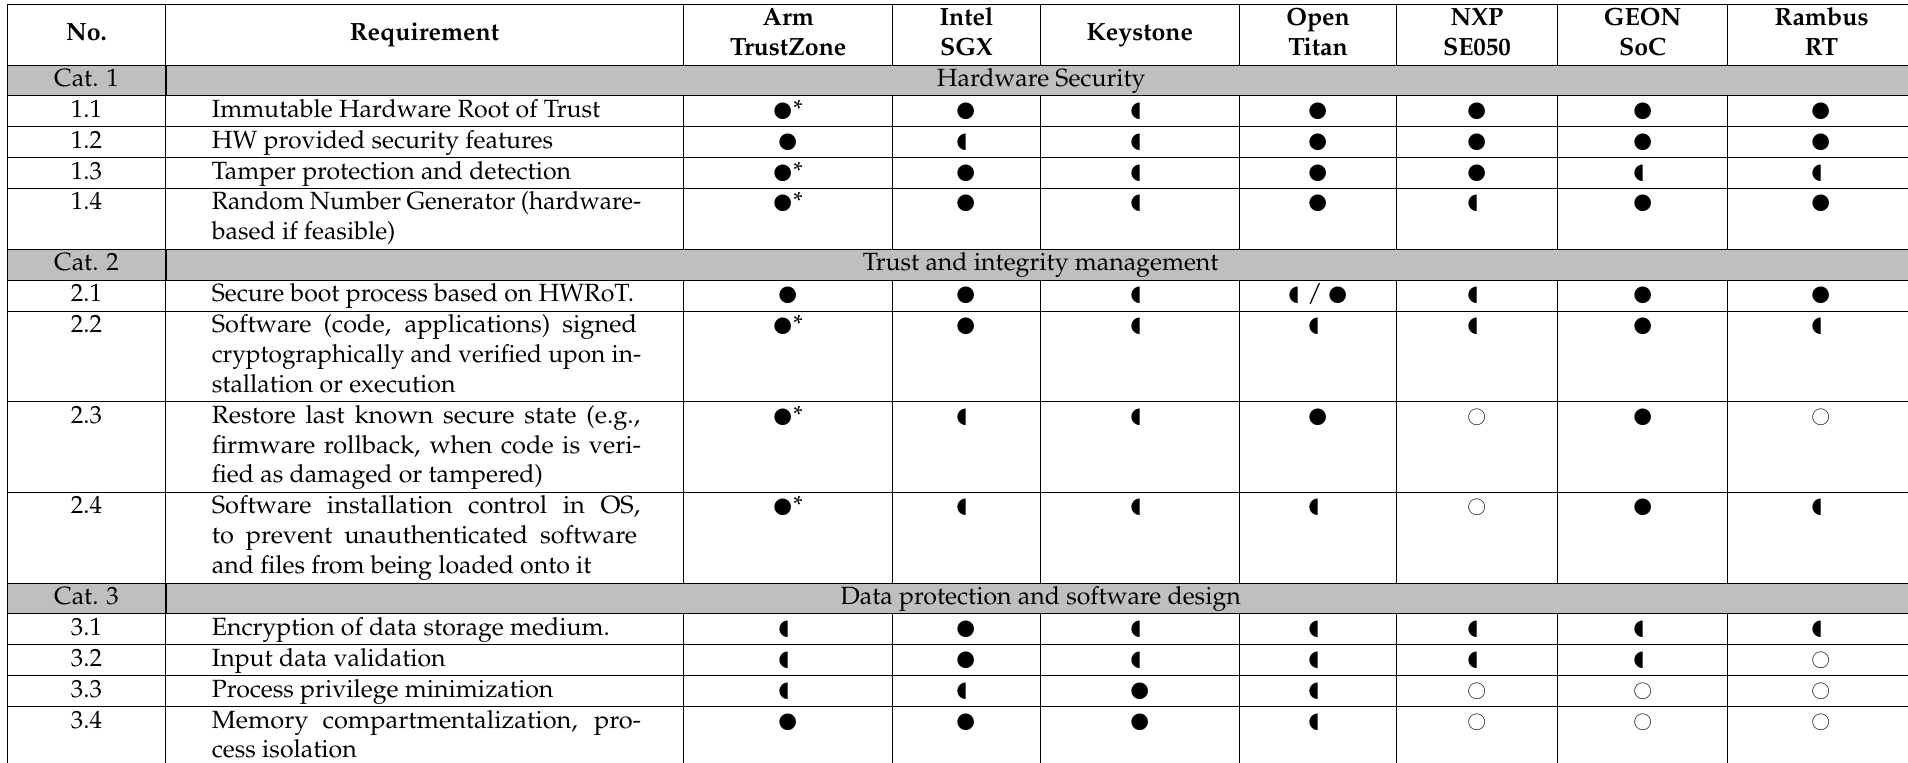
Table 2. Comparison of the state-of-the-art against the synthesized requirements for secure IoT devices. Arm Requirement TrustZone